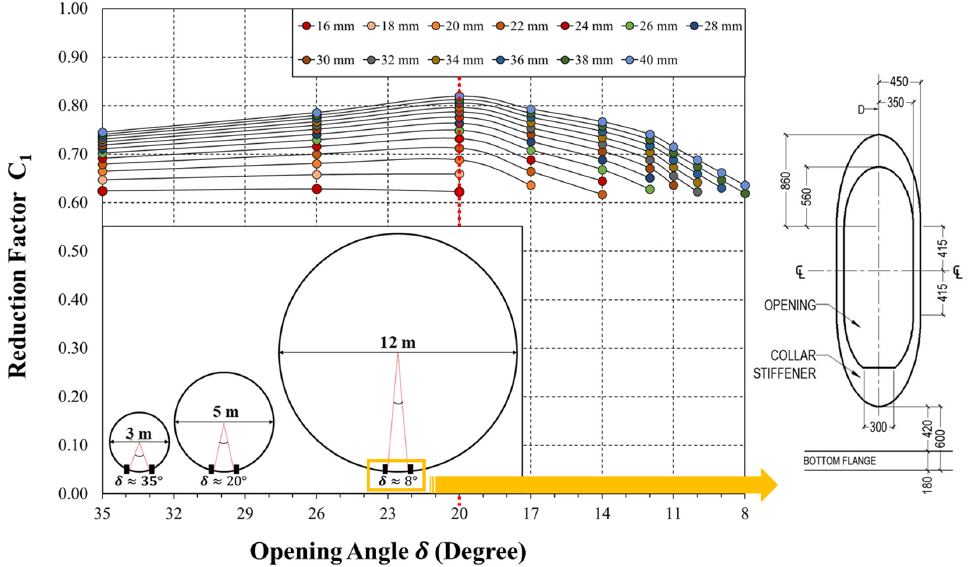
Figure 4. Trend of the strength reduction factor ( C 1 ) based on the opening angle ( δ ). As the angle of installation of the cylindrical shell opening decreases, the reduction factor increases linearly. However, when the angle is less than 20°, the reduction factor gradually decreases. Consequently, in the design standard, when the angle of installation of the cylindrical shell opening is 20° or less, the influence of the section loss is considered to be small. Based on this, a large tower with a small opening angle should have a different collar stiffener design. However, the design standard does not deal with stiffener thickness.